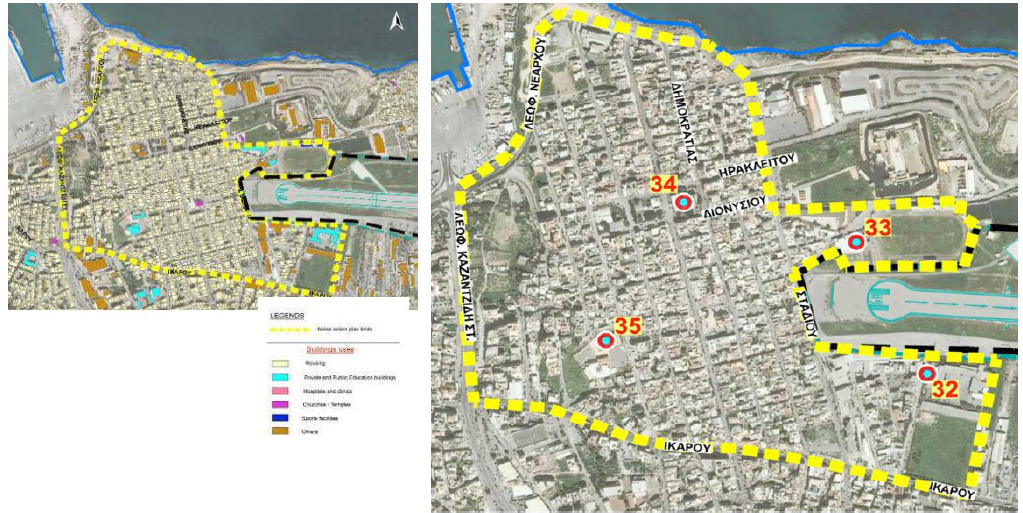
Fig. 7. 24h measurements locations & Points of interest at Alikarnassos study